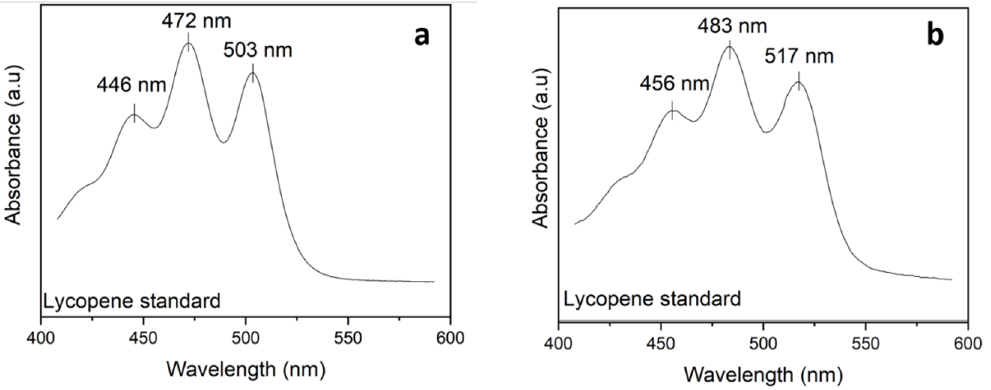
Figure 3. UV–vis spectra of lycopene standard in different solvents (1.36 mg lycopene/100 g solvent): ( a ) hexane:ethanol:acetone (2:1:1) and ( b )